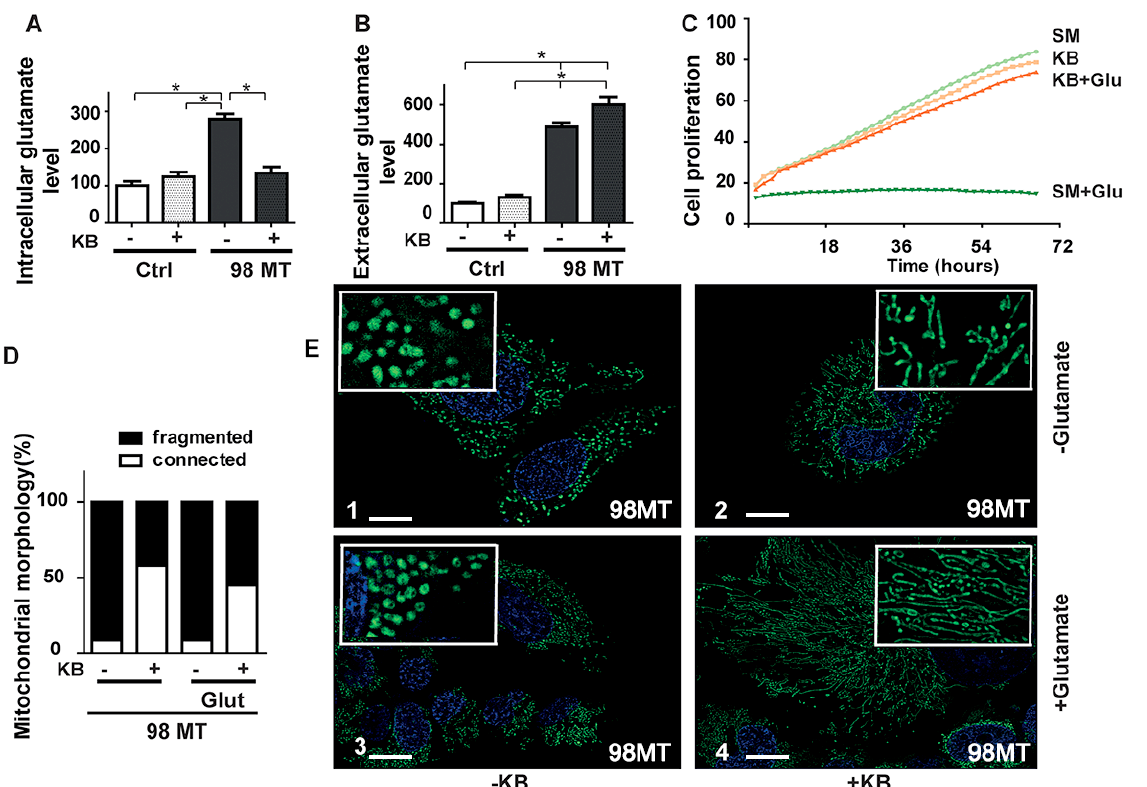
Figure 4. Treatment with ketone bodies restores a normal intracellular glutamate concentration and improves the mitochondrial network in MELAS cells. ( A ) Intracellular and ( B ) extracellular glutamate levels in Ctrl and 98% MT cells treated for 48 h with (+) or without ( − ) KB. Results are from at least four independent experiments, expressed as the mean ± SEM relative to Ctrl cells. (* p < 0.05). ( C ) Cell growth of 98% MT cells cultured in a standard medium (SM, light green curve), or exposed to KB (orange curve), or with 50 μ M glutamate (Glu) and KB (red curve) or a standard medium (SM+Glu, green curve). ( D ) Mitochondrial morphology, and percentages of fragmented (black) or connected (white) mitochondria in 98% MT cells with (+) or without ( − ) KB, and with or without glutamate (30 μ M). ( E ) Representative images showing the MitoTracker (green fluorescence) and Hoechst (blue fluorescence) staining of 98% MT cells, incubated for 24 h in E-1: standard medium, E-2: with KB, E-3: with glutamate (Glu), and E-4: with Glu and KB. Scale Bar: 10 um.